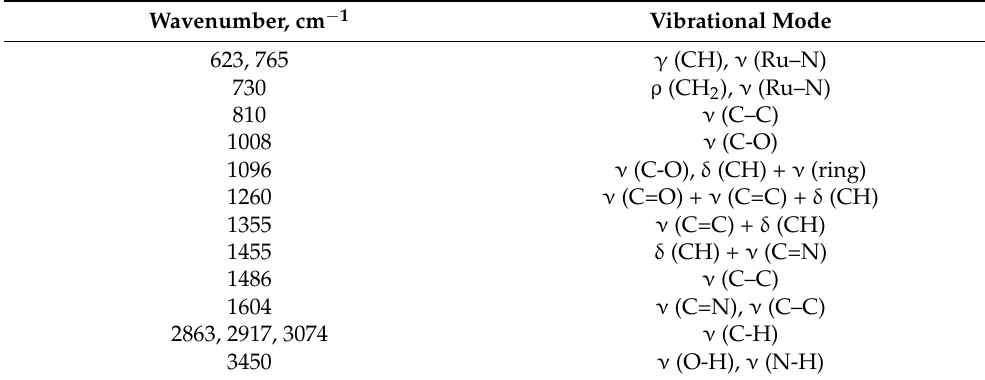
Table 1. Elemental composition of hybrid materials.